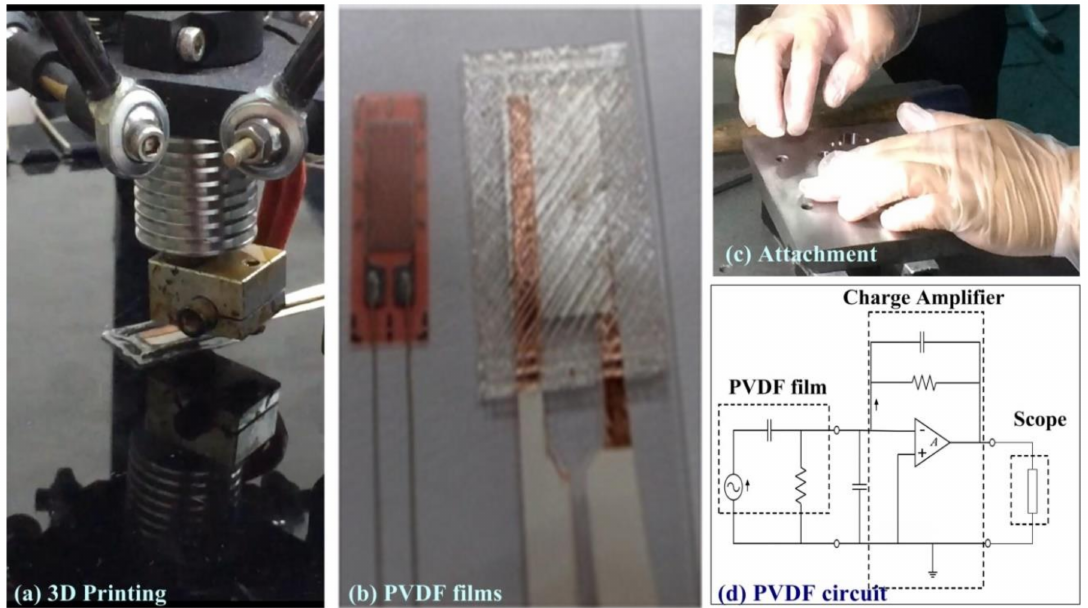
Figure 4. Customized PVDF film: ( a ) packaging of PVDF film sensor using a 3D printing machine; ( b ) comparison of commercial strain gauge and proposed PVDF sensor; ( c ) installation of PVDF film in mechanical mold; and ( d ) circuit used in charge